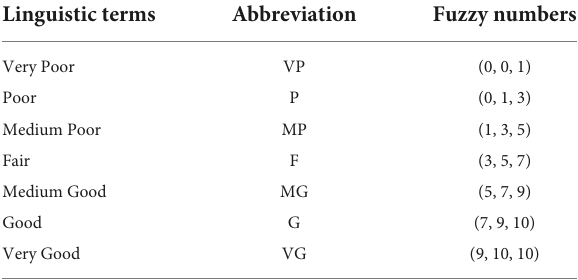
TABLE 2 Fuzzy linguistic variables for qualitative attribute